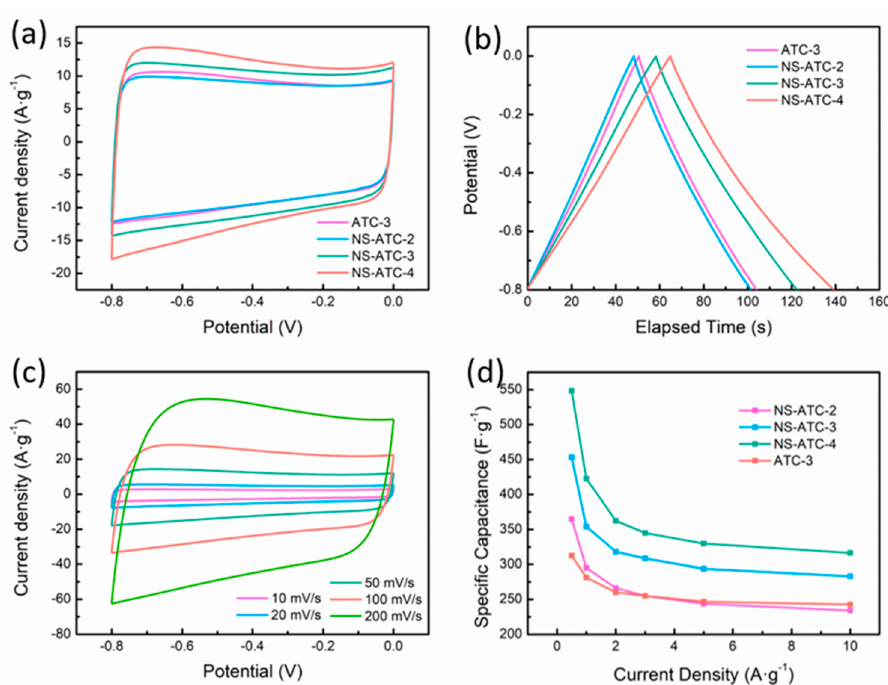
Figure 6. ( a ) CV curves of nondoped and doped samples at 50 mV · s − 1 ; ( b ) GCD curves of nondoped and doped samples at 3 A · g − 1 ; ( c ) CV curves of NS-ATC-4; ( d ) Specific capacitance of samples at growing current densities.